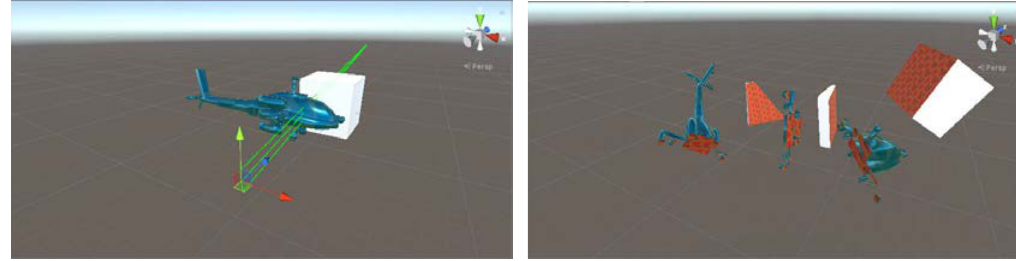
Figure 5. Example of cutting of complex objects .